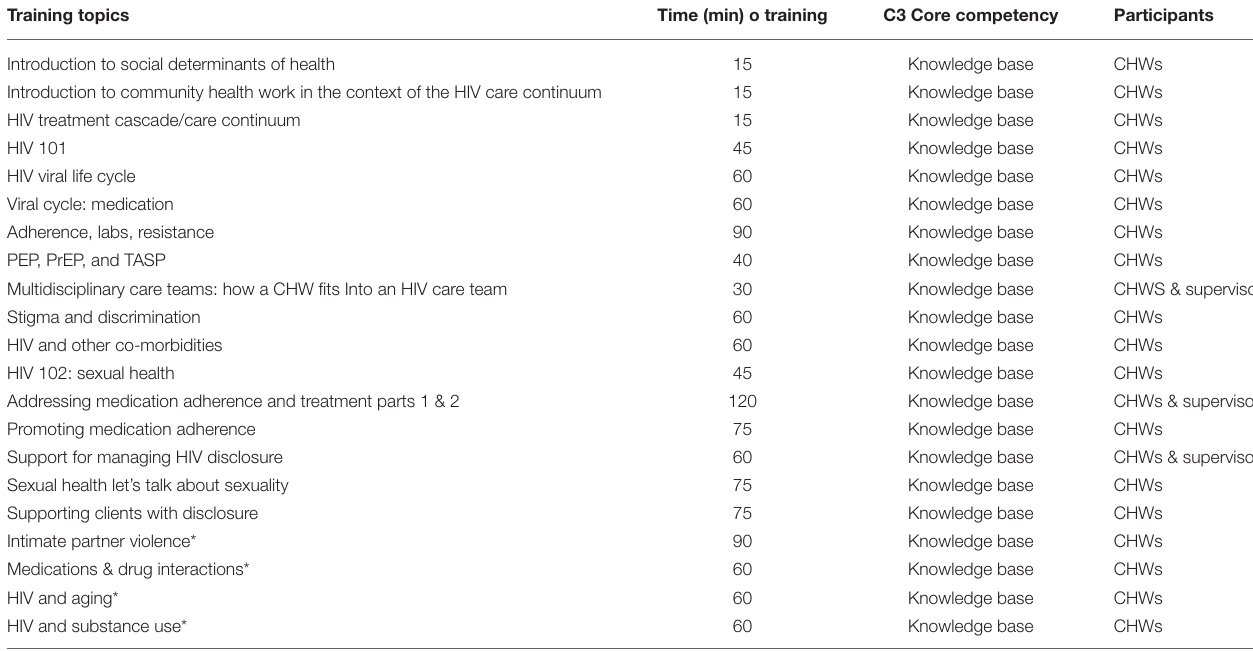
TABLE 1 | HIV core topics and hours completed by CHWs and